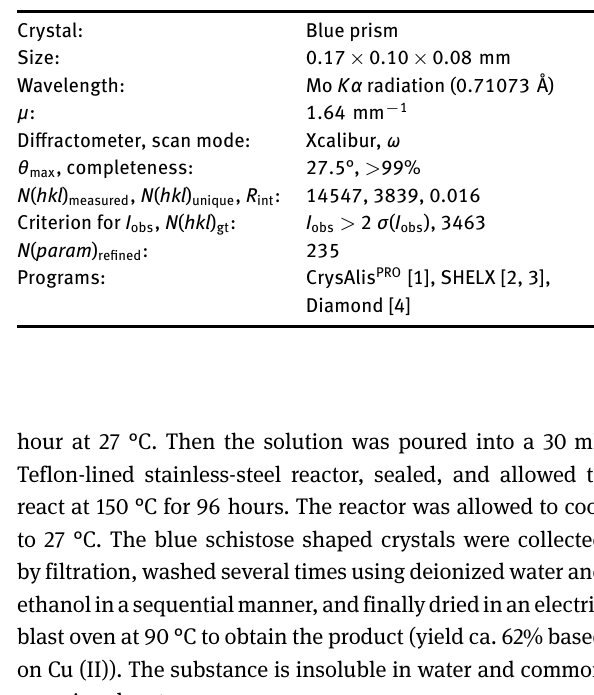
Table 1: Data collection and